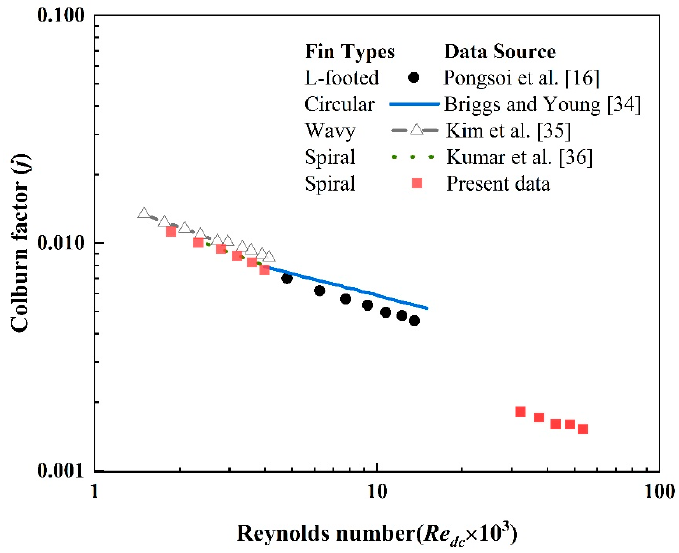
Figure 6. Comparison with Colburn factor with data from